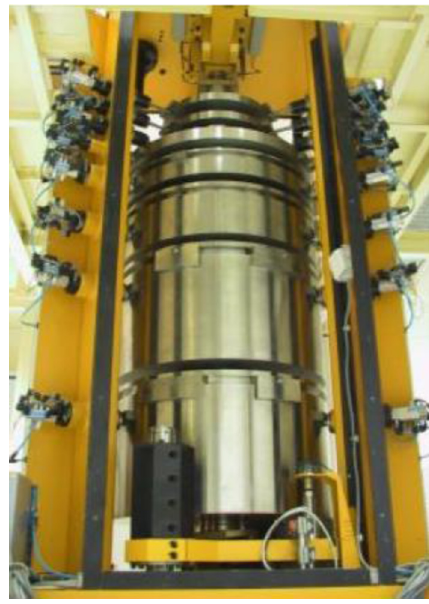
Fig. 4. Standard dead weights machine used (1000 kN).